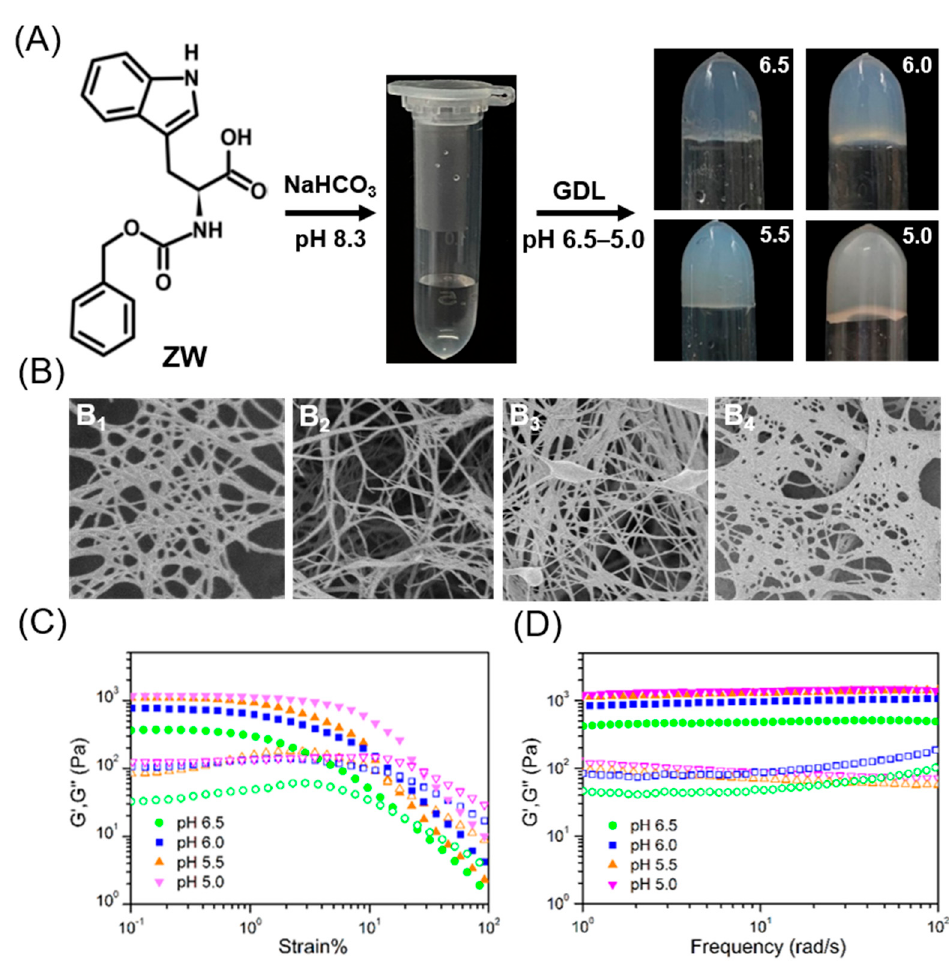
Figure 1. ( A ) Demonstration of the facile preparation of ZW/GDL hydrogels at different pH. ( B ) B1, B2, B3, and B4 refer to SEM images obtained at pH 5.0, 5.5, 6.0, and 6.5, respectively (scale bar: 100 nm). ( C ) strain-dependent sweep, and ( D ) dynamic frequency sweep of hydrogels at pH 6.5, pH 6.0, and pH 5.0.